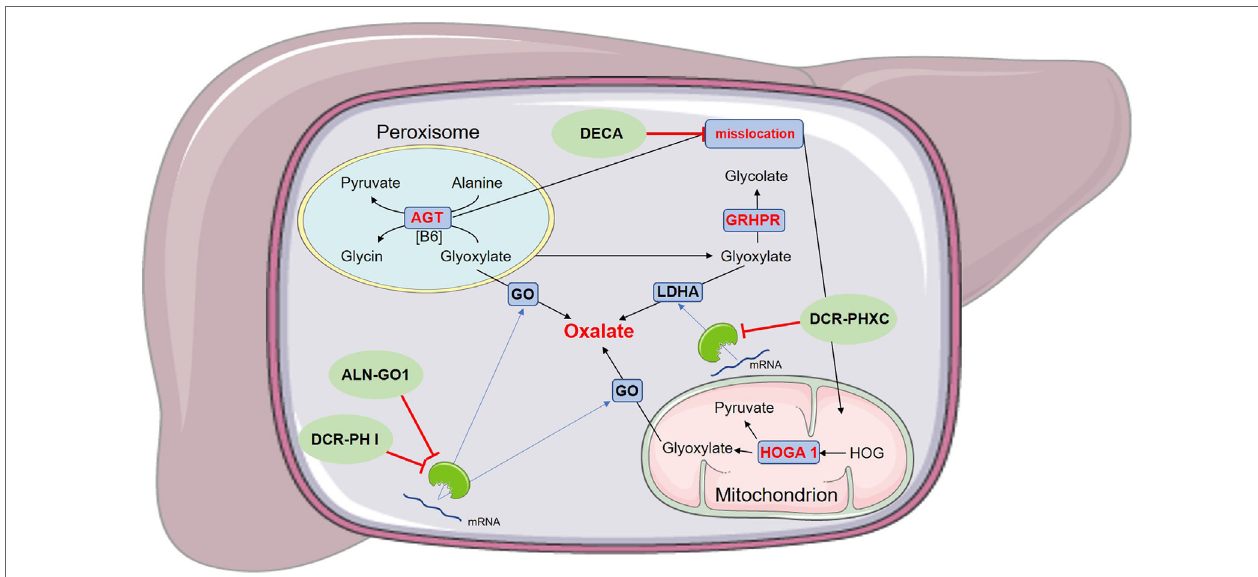
FiGURe 2 | Schematic figure of the mode of action of experimental drugs for primary hyperoxaluria (PH) I. ALN-GO1 and DCR-PH I are RNA interference (RNAi)-based drugs, preventing the translation of glycolate oxidase (GO) and thus reducing endogenous oxalate production. DCR-PHXC as well is an RNAi-based drug targeting the liver-specific lactate dehydrogenase A (LDHA), also reducing endogenous oxalate production. Dequalinium chloride (DECA) prevents the misslocation of alanine:glyoxylate aminotransferase (AGT). This is only applicable for a certain PH I mutation (P11LG170R allele), since other mutations do not cause a misslocation of